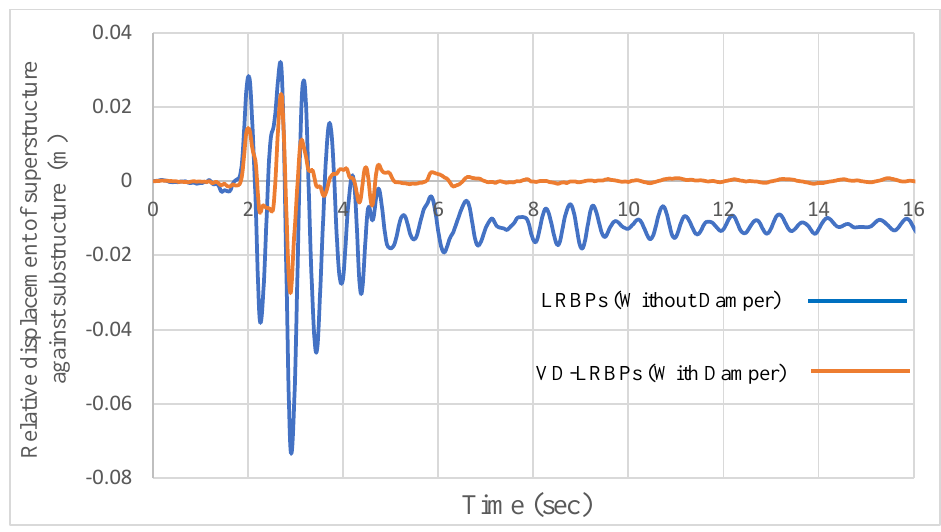
Figure 18. The relative displacement of superstructure versus substructure histories under Northridge earthquake.